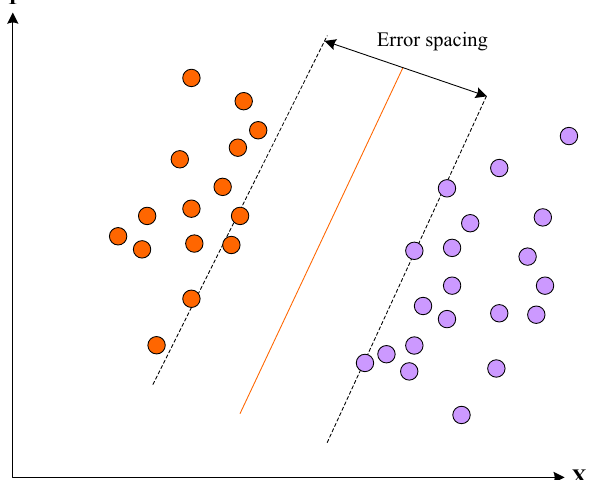
Fig. 3 Structural model of support vector